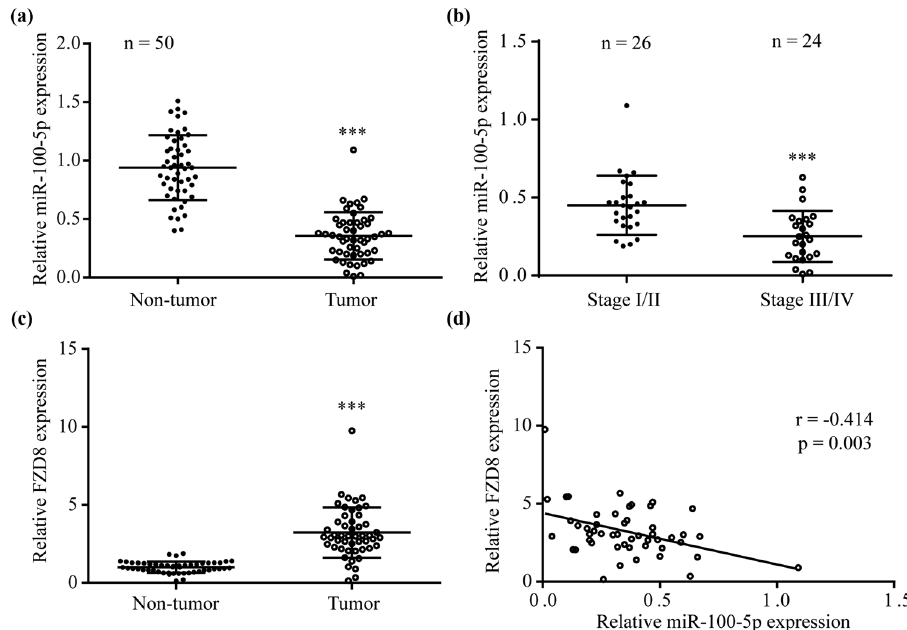
Figure 5: miR - 100 - 5p was inversely associated to FZD8 in PTC: ( a ) RT - PCR showed that miR - 100 - 5p was lower in PTC tissues than non - tumors tissues from 50 patients with PTC, ( b ) miR - 100 - 5p levels were relatively lower in tumors at Stage III/IV than those at Stage I/II, ( c ) RT - PCR showed that FZD8 mRNA expression was higher in PTC tissues than non - tumors tissues from 50 patients with PTC, and ( d ) the Pearson correlation analysis indicated an inverse correlation between miR - 100 - 5p and FZD8 in PTC tissues. ***, p <